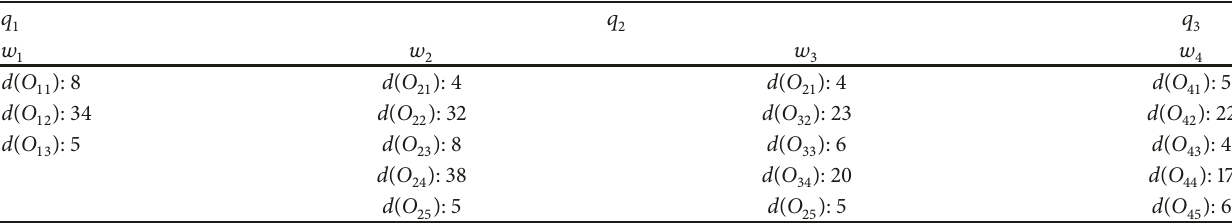
Table 5: Processing times of operations for the FMS in Figure 4.